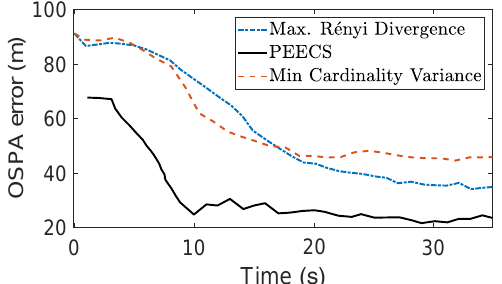
Figure 9. Optimal Sub-Pattern Assignment (OSPA) errors of PEECS compared to the sensor control methods suggested by Hoang et al. in [32] (as reported in